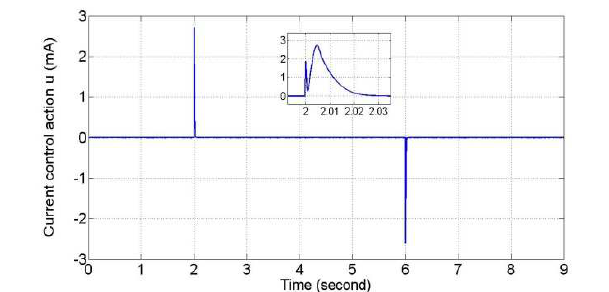
Fig. 15. Current control input under parametric uncertainties with desired piecewise piston position.